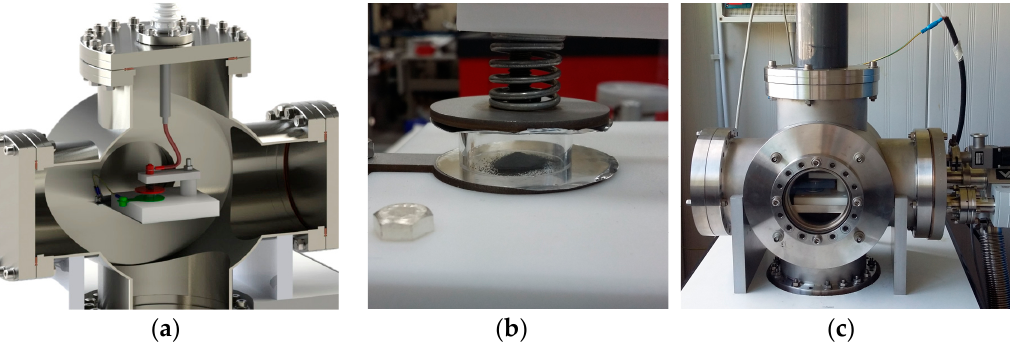
Figure 9. HIVIPP deposition system: ( a ) 3D general scheme; ( b ) photo of the deposition chamber: Substrates attached to the two high voltage electrodes in parallel and powders contained by the quartz cylinder in between; ( c ) photo of the working